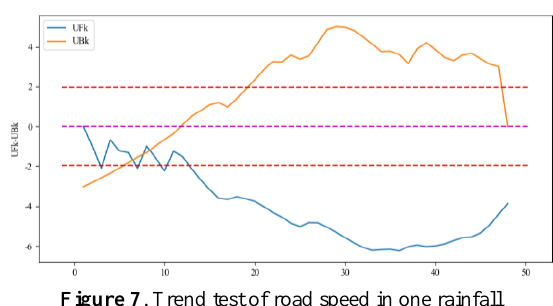
Figure 7 . Trend test of road speed in one rainfall